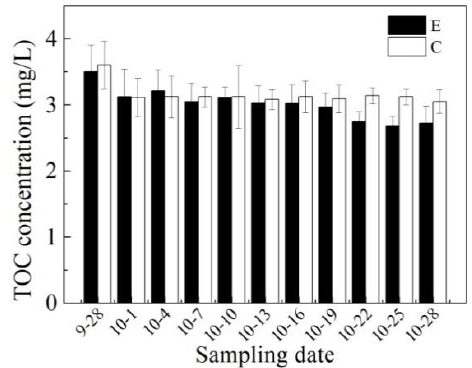
Figure 3. Changes in total organic carbon (TOC) concentration (mean values) in the enhanced area and control area during the running period of the water-lifting aeration system. In the legend, C stands for “control area” and E for “enhanced area”.